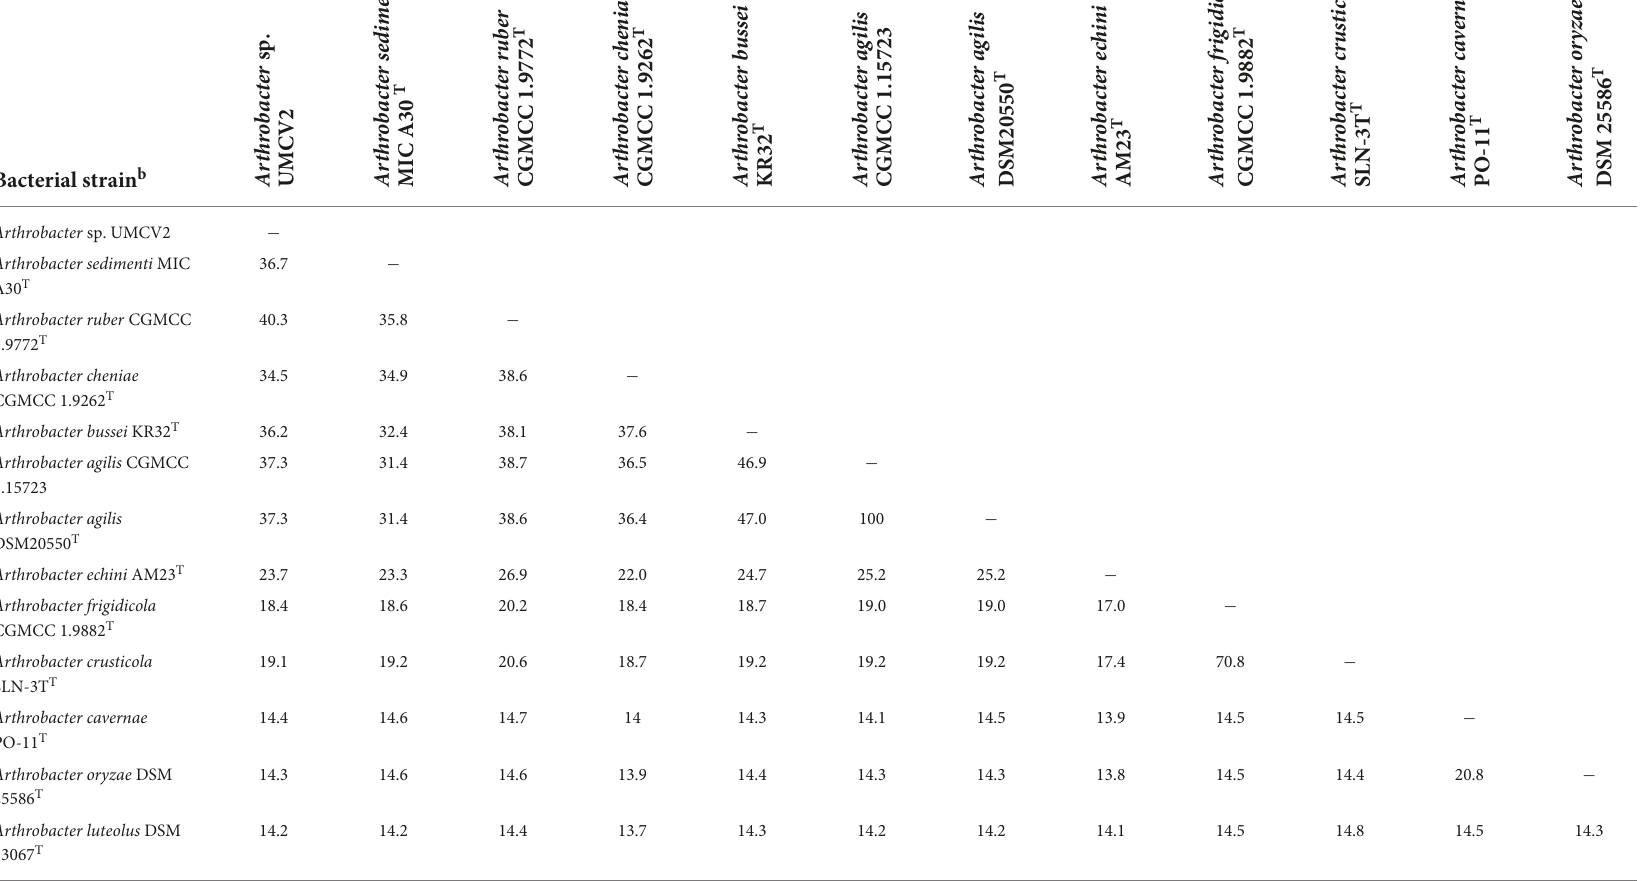
TABLE 2 Genomic relatedness matrix of Arthrobacter sp. UMCV2 and closed-related type strains calculated as digital DNA–DNA hybridization (dDDH) percentages a .